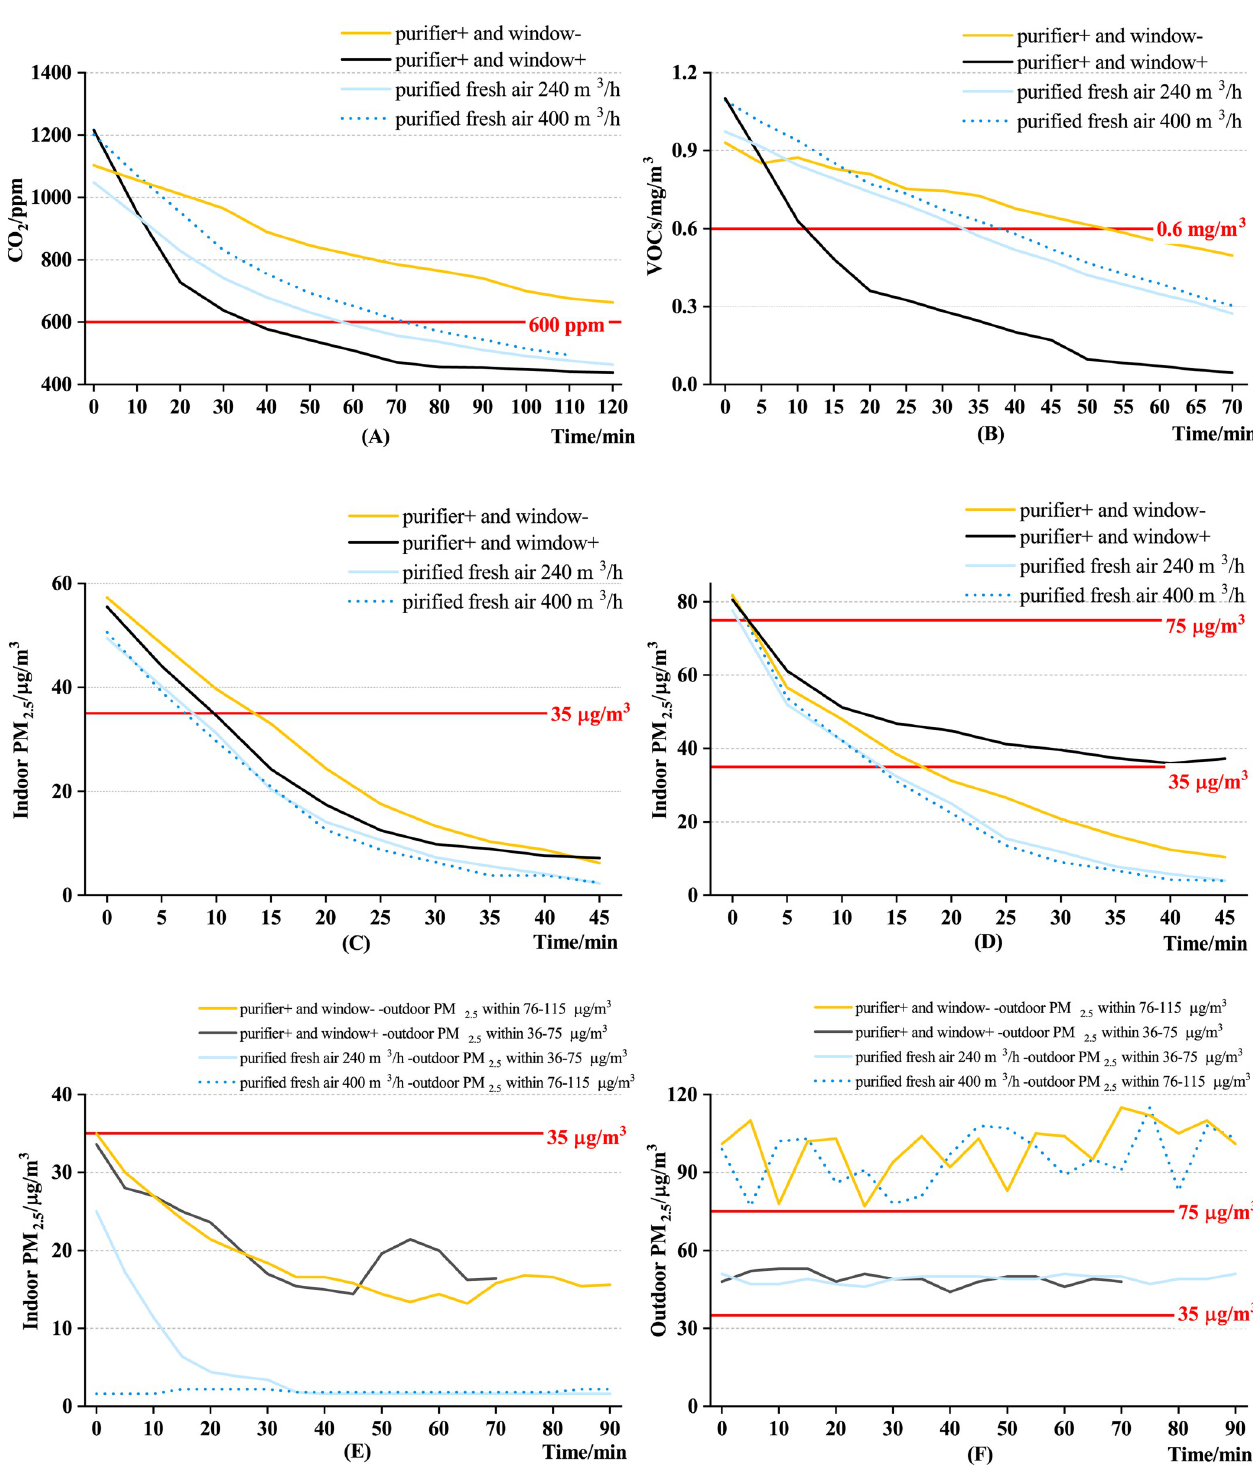
Fig 3. Comparison of the control methods under a single pollutant condition. (A) Indoor CO 2 exceeding the standard. (B) Indoor VOCs exceeding the standard. (C) Indoor PM 2.5 at a good level. (D) Indoor PM 2.5 at a light pollution level. (E) Indoor PM 2.5 concentration when outdoor PM 2.5 exceeds the standard. (F) Outdoor PM 2.5 concentration when outdoor PM 2.5 exceeds the standard.